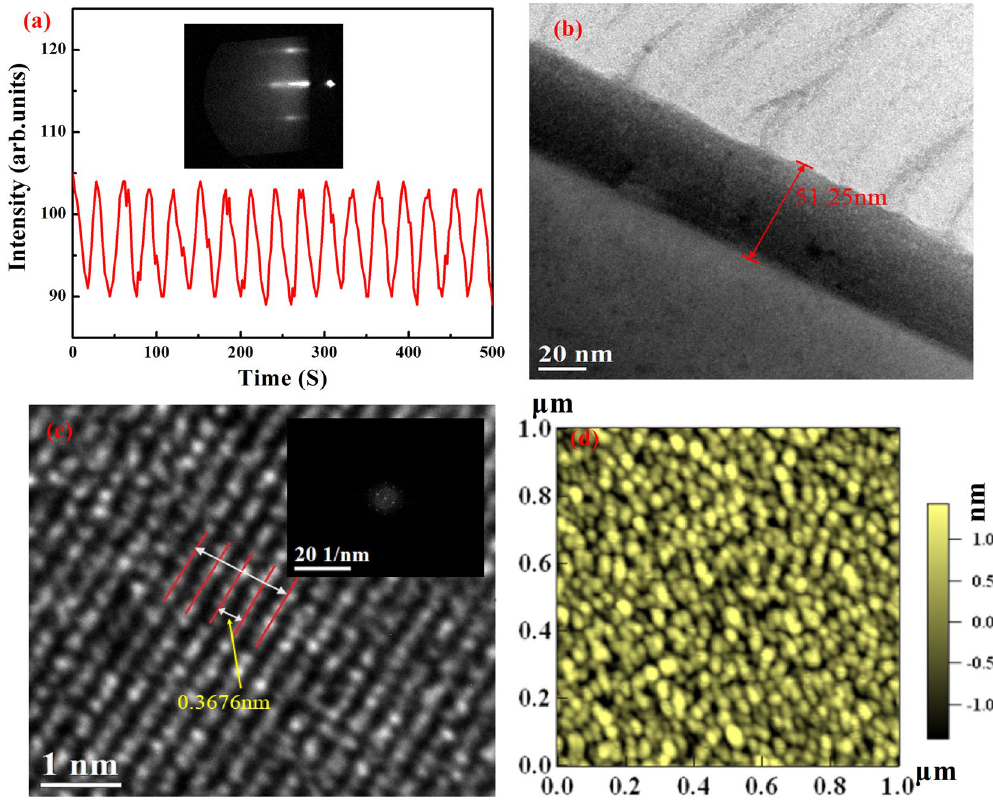
Figure 1. Details about RHEED pattern and the sample structure. ( a ) RHEED patten and intensity oscillations during deposition. Cross-sectional morphologies ( b ), macroscopic structure and FFT patten ( c ) and surface ( d ) of the SL